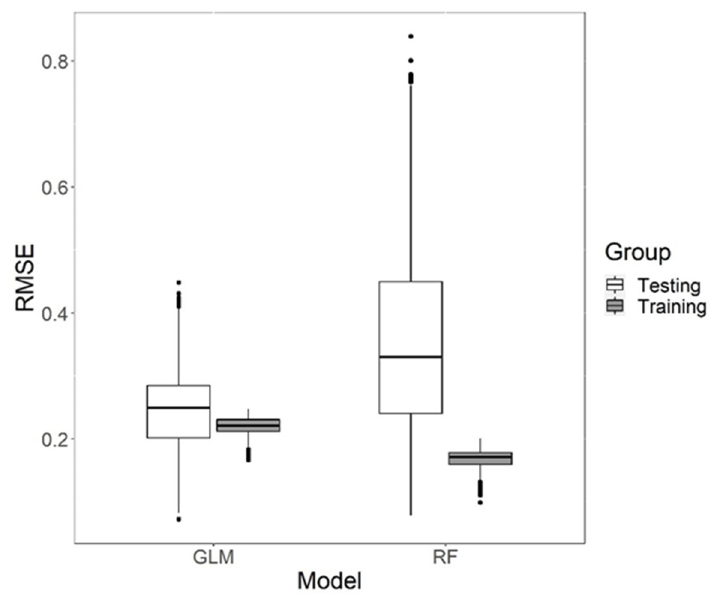
Figure 4. Performance of the General Linear Model (GLM) and Random Forest (RF) model after 5-fold cross validation iterated 1000 times to eliminate seed bias for the training and testing data. The solid line represents median Root Mean Square Error (RMSE), the upper and lower hinges form the 1st and 3rd quartiles while the whiskers extend to the highest and lowest value within 1.5 times inter-quartile range from the two hinges. The black dots represent outliers beyond the range of whiskers.